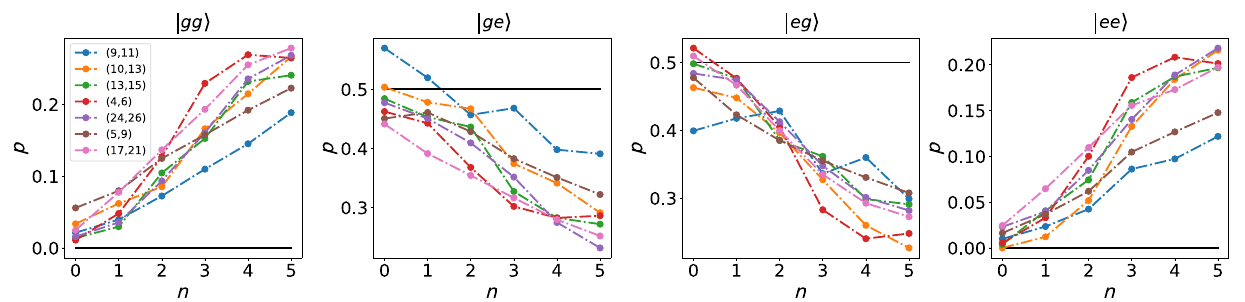
FIG. 11. The probability of finding the states | gg (cid:5) , | ge (cid:5) , | eg (cid:5) , and | ee (cid:5) (from left to right) through a projective measurement in the computational basis as a function of the number of steps in the MCM on IBMQ_TORONTO , when the initial state is the subradiant state. The continuous black lines show the theoretical prediction based on the master equation. The markers on the dash-dotted lines show experimental values. The different colors denote different initial pairs of system qubits in the topology of IBMQ_TORONTO , each of which interacts with a corresponding train of ancillas.